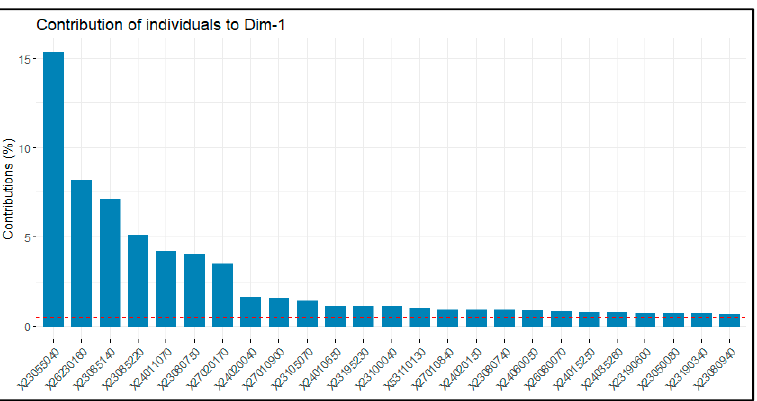
Figure 7. First PCA component contributions of individuals. Here, the weather stations and the percentage of variance contributions are identified. Source: author’s processing.